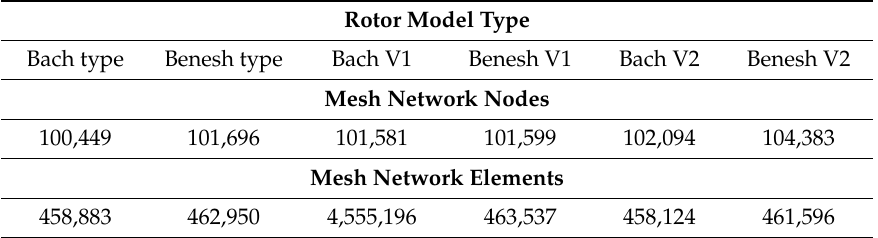
Table 5. Main rotor model types considered for numerical analysis (dimensions in mm)